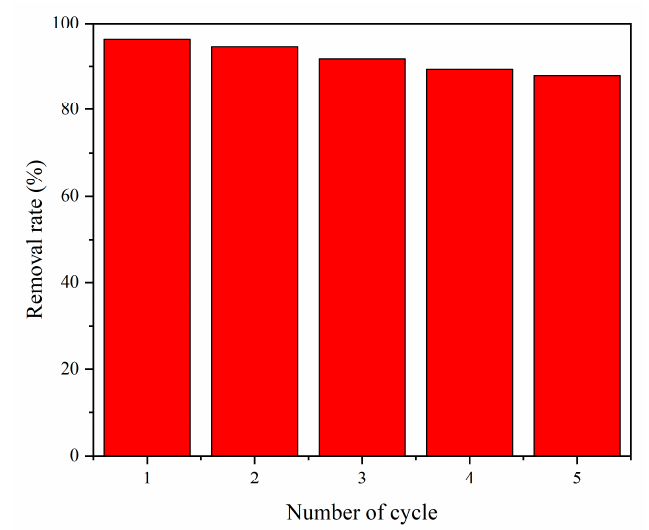
Figure 10. Reusability of TH-2 composite to the degradation of MB.